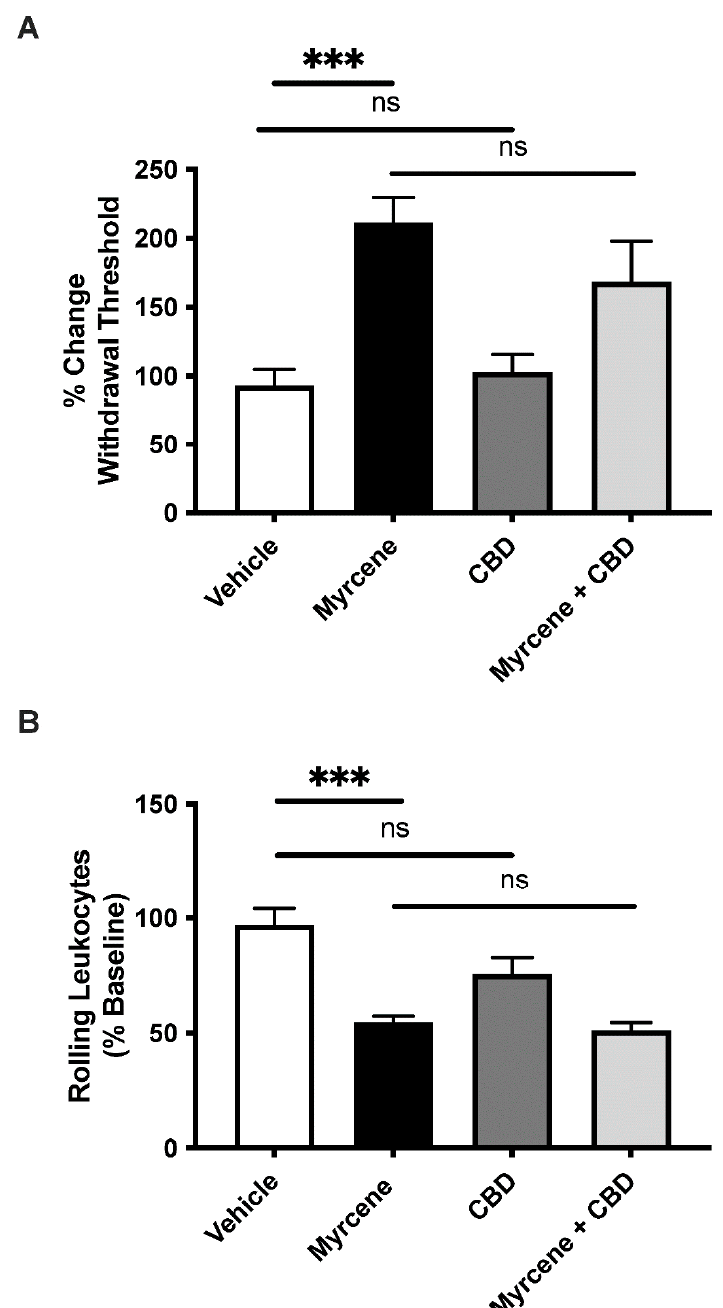
Figure 3. The effect of co-administration of low-dose cannabidiol (CBD) and myrcene on joint pain and inflammation. While low-dose myrcene reduced hindlimb pain ( A ) and leukocyte rolling ( B ), the addition of cannabidiol (CBD) had no additional effect on these analgesic or anti-inflammatory responses. ns—not significant, *** p < 0.001, one-factor RMANOVA with Bonferroni’s post hoc test. Data are means ±